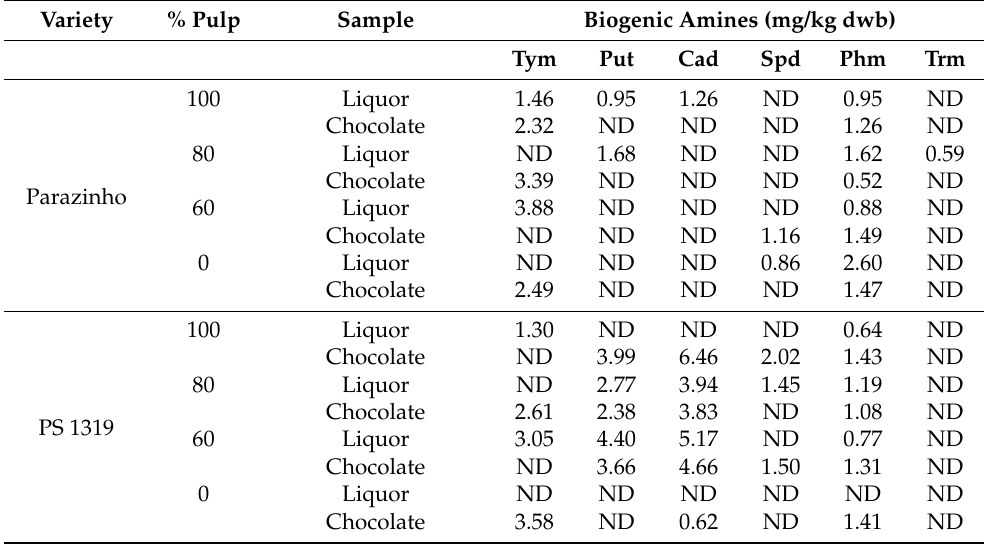
Table 2. Levels of free bioactive amine in liquor and chocolate of two varieties of cocoa (PS 1319 and Parazinho) from Bahia, Brazil, using different proportions of pulp (100, 80, 60, and 0%). Variety % Pulp Sample Biogenic Amines (mg/kg dwb) Tym Put Cad Spd Phm Trm 100 Liquor Parazinho